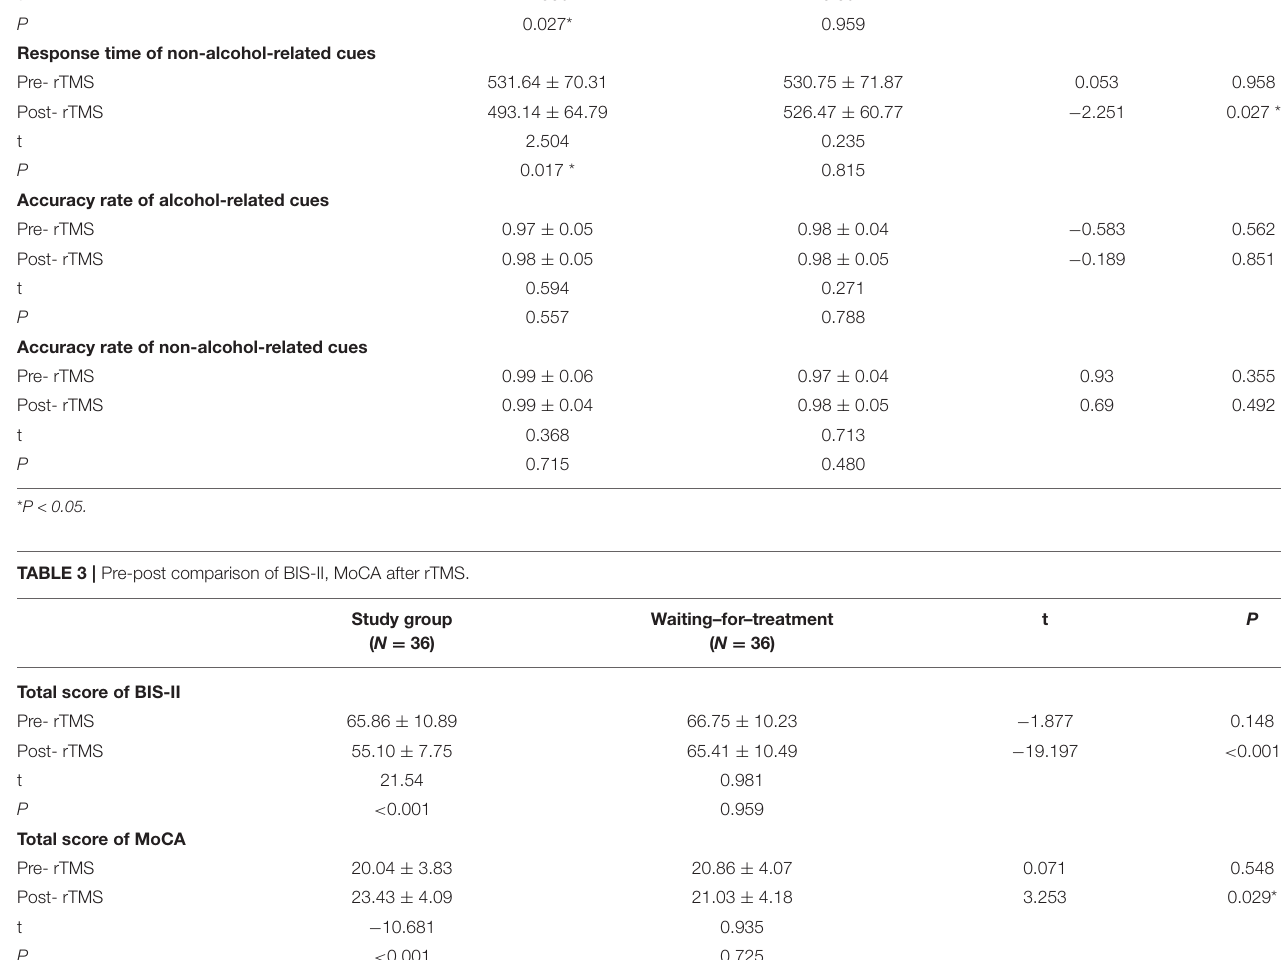
Study group ( N = 36)